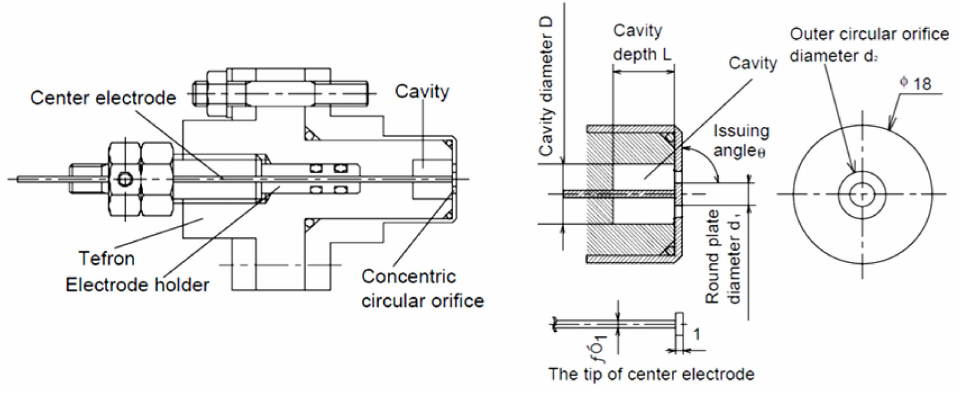
Figure 3. Cross sectional view of plasma jet igniter